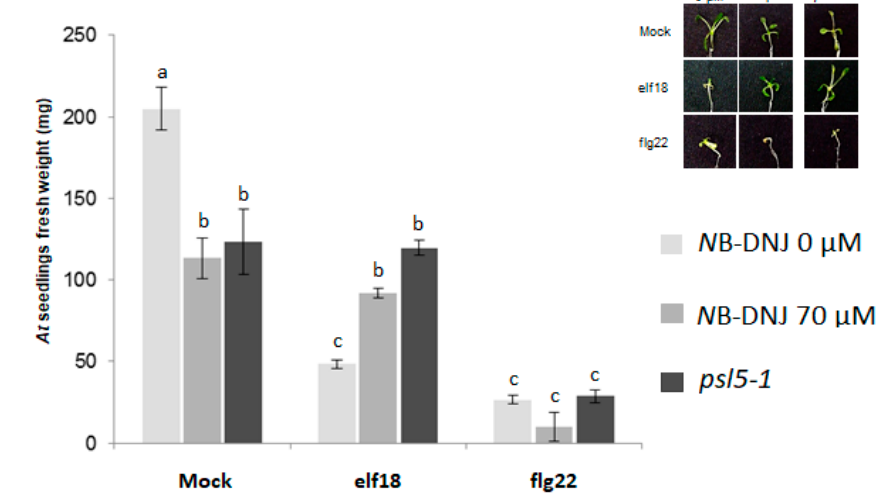
Figure 2. In planta ER α –glucosidase II assay. Arabidopsis thaliana ( At ) Col-0 seedlings (wild-type, WT) were grown in presence or absence of N B-DNJ (70 µ M) and their growth was compared to that of psl5-1 seedlings used as controls. N B-DNJ treatment was combined with that of elf18 or flg22. In presence of N B-DNJ, the growth trend of psl5-1 control seedlings was indistinguishable from WT ones, irrespective of treatment with elicitors. Inset shows representative pictures of 15-day-old seedlings (five seedlings per well) germinated and grown with or without N B-DNJ and elicitors. Values represent the mean of at least five independent experiments ( ± s.e.; n = 5) with similar results in each experiment. Each letter indicates a group of samples whose values are statistically equivalent to the ones in the same group, at the ( p < 0.01) level determined by ANOVA with Scheff è ’s post hoc test. Note: the differences in the weights of seedlings from those in the experiment in Figure 1, which may be due to slight variations in seed germination times (see methods), did not affect the sensitivity of plants to elicitors after N B-DNJ treatment.